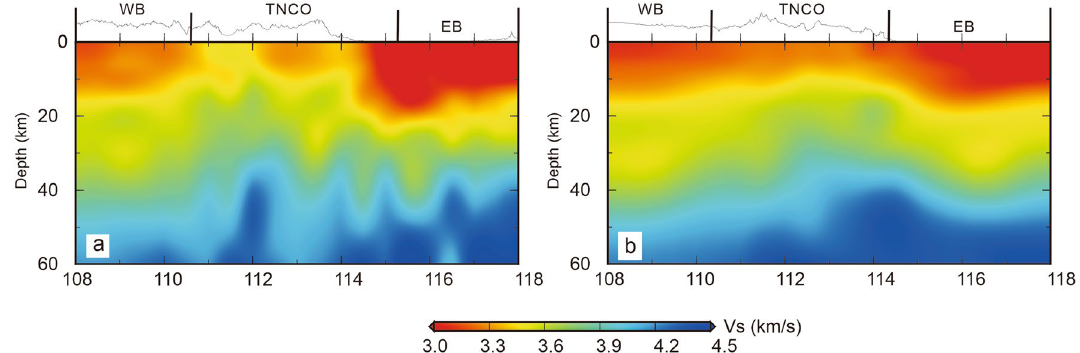
Figure 5. S-wave velocity profiles [the figure was generated by Chuansong He using Generic Mapping Tools (https:// www. gener ic- mappi ng- tools.